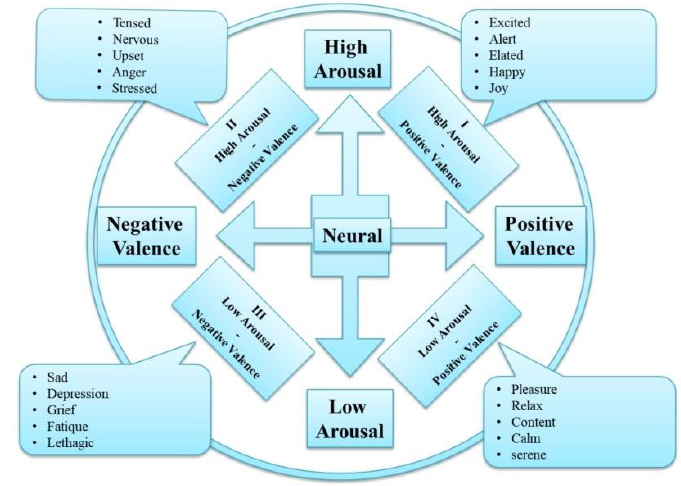
Figure 1. Circumplex emotional model to exhibit complex emotions.